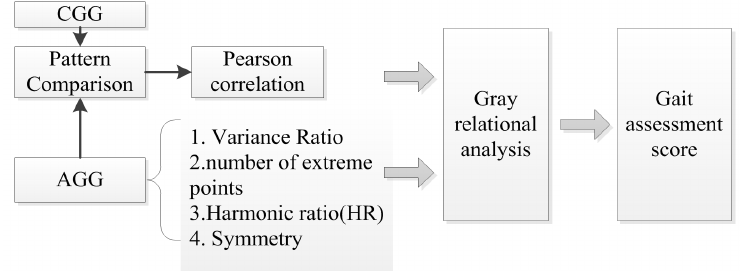
Figure 3. The flow chart of our gait assessment model.